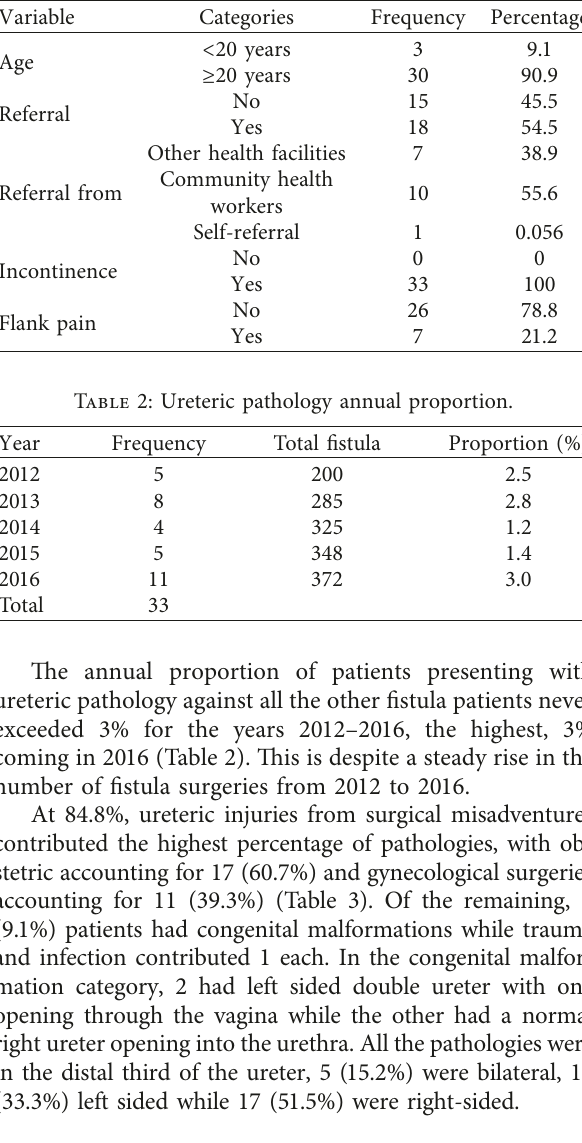
Figure 1: Age distribution. Table 1: Age, referral status, and clinical presentation.